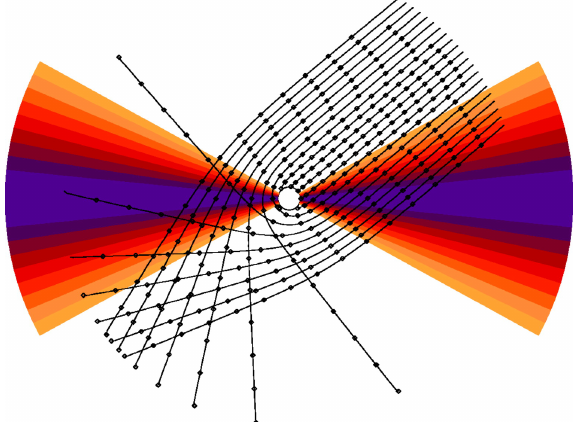
Figure 1. Schematic diagram of a typical ray-tracing procedure. The path of a photon is integrated along geodesic trajectories from a distant observer to the region close to the black hole. The photons may either terminate at the horizon (innermost circle) or escape to infinity. The source of photons in this example is an accretion disk with layers (in color) of different temperature. Figure taken from Reference [37] with kind permission from J. Schnittman and reproduced by permission of the